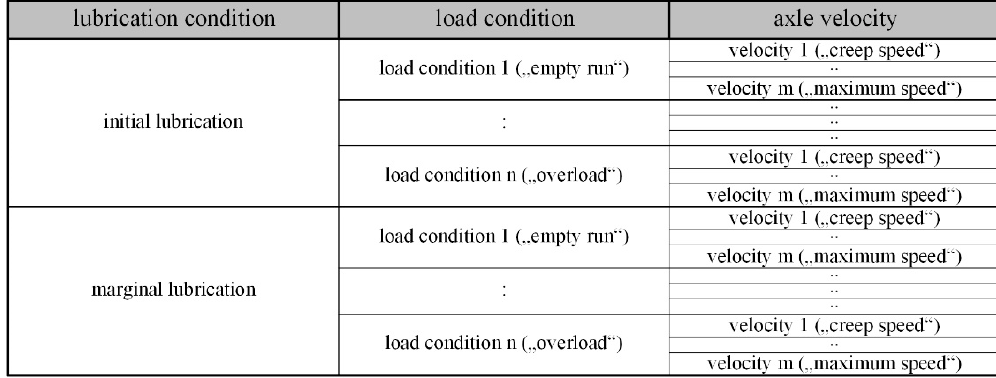
Figure 10. Excerpt from the experimental plan.